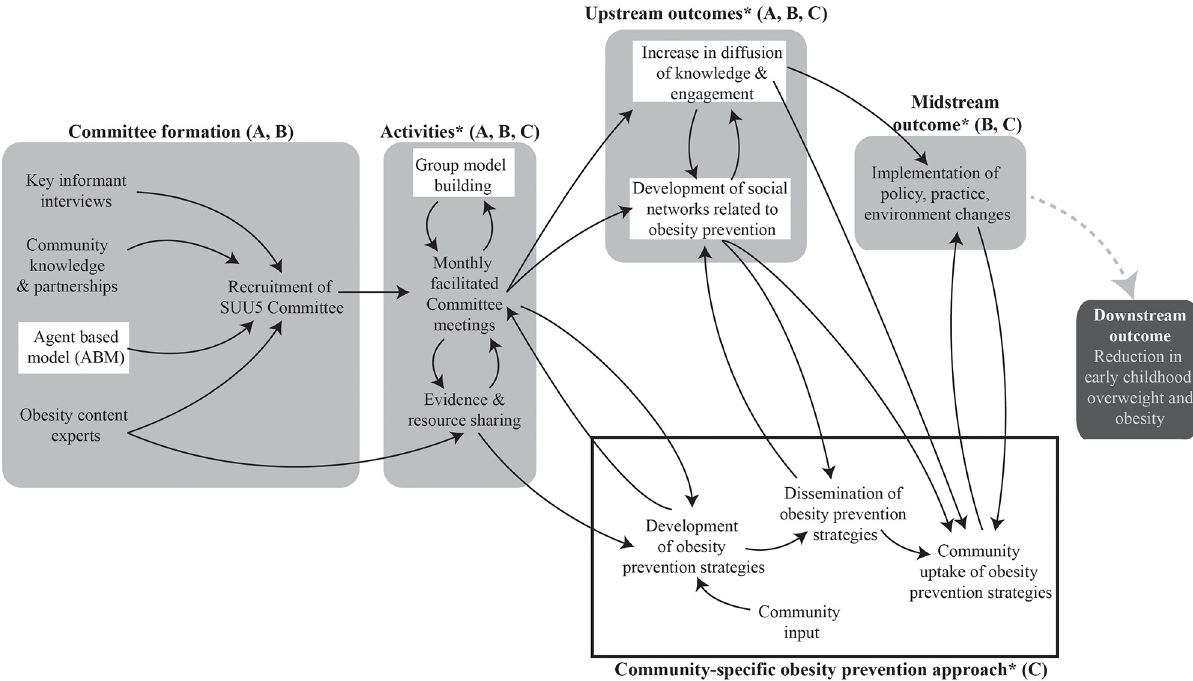
Fig 1. Stakeholder-driven Community Diffusion conceptual framework. Notes: (A) White box indicates use of systems science; (B) Light gray shaded boxes indicate a priori conceptual framework; (C) � indicates data collection points .